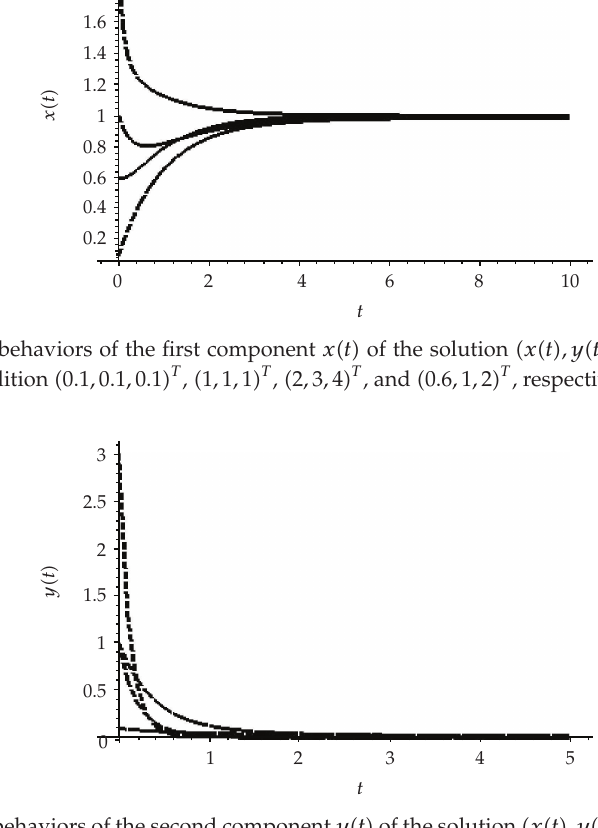
Figure 2: Dynamic behaviors of the second component y (cid:3) t (cid:4) of the solution (cid:3) x (cid:3) t (cid:4) ,y (cid:3) t (cid:4) ,z (cid:3) t (cid:4)(cid:4) T to system (cid:3) 3.1 (cid:4) with the initial condition (cid:3) 0 . 1 , 0 . 1 , 0 . 1 (cid:4) T , (cid:3) 1 , 1 , 1 (cid:4) T , (cid:3) 2 , 3 , 4 (cid:4) T , and (cid:3) 0 . 6 , 1 , 2 (cid:4) T ,